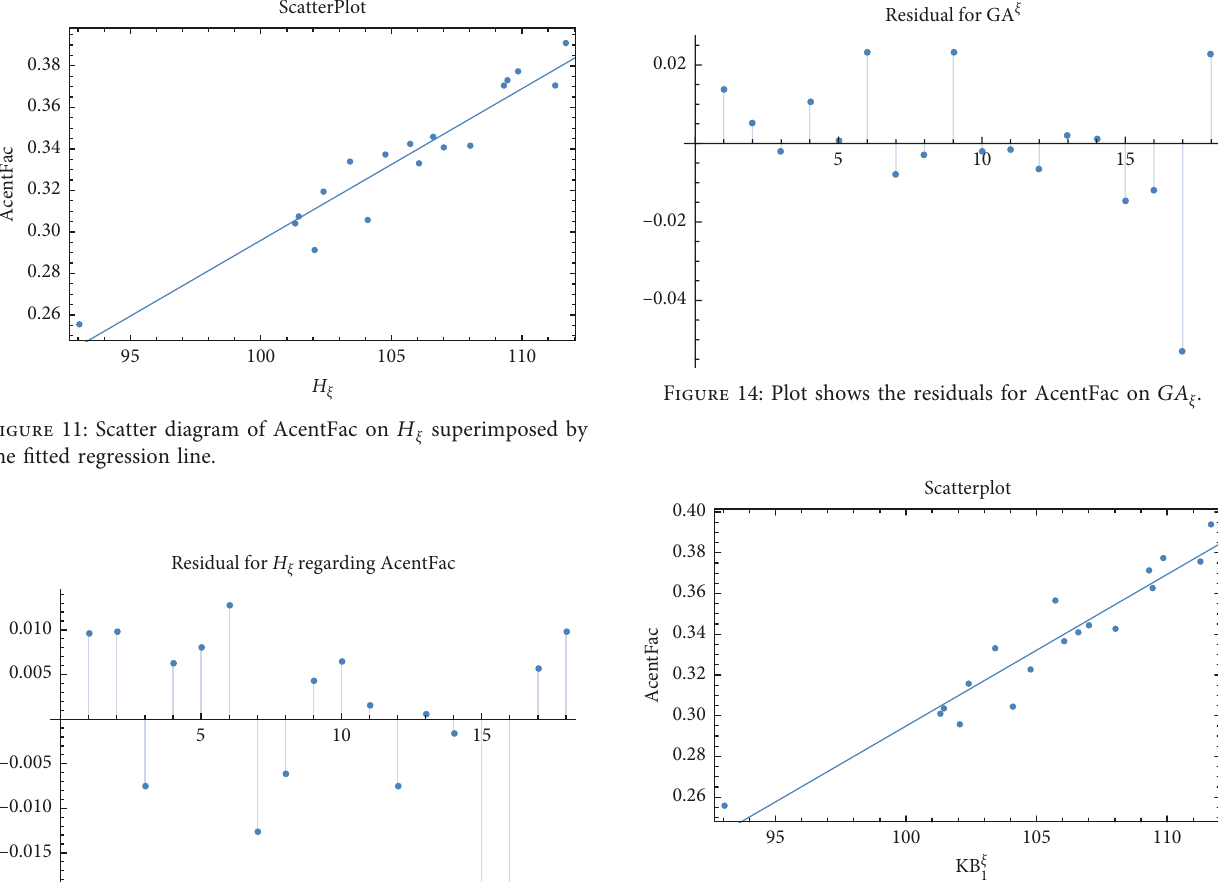
Figure 15: Scatter diagram of AcentFac on KB ξ . the fitted regression line. ξ